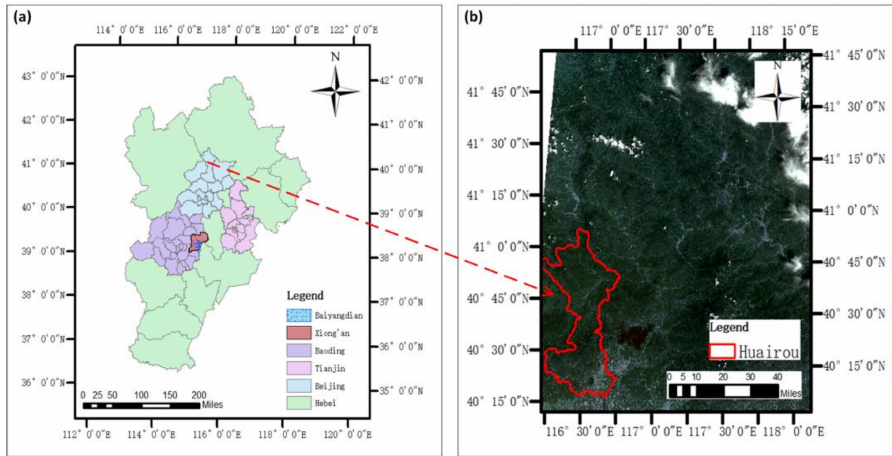
Figure 7. Location of case study area two ( a ) map projection; ( b ) satellite photo (the GF-1 imagery of Huairou, Beijing; data date: 21 August 2021).